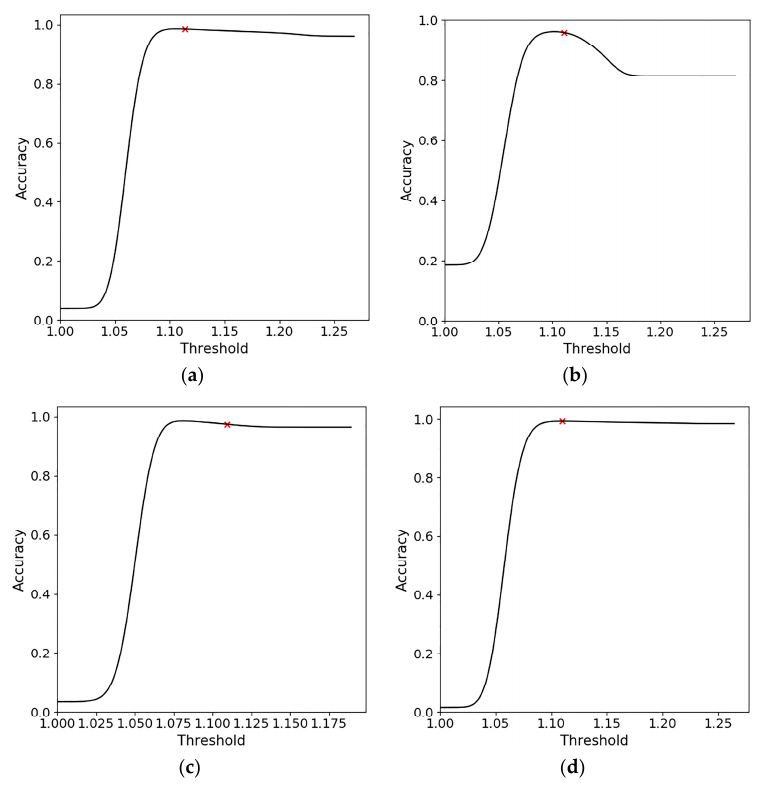
Figure 13. Relationship between oil spill detection accuracy and threshold based on PR r . ( a – d ) are Cases 1–4, respectively. The red symbol × indicates the thresholds for our method.